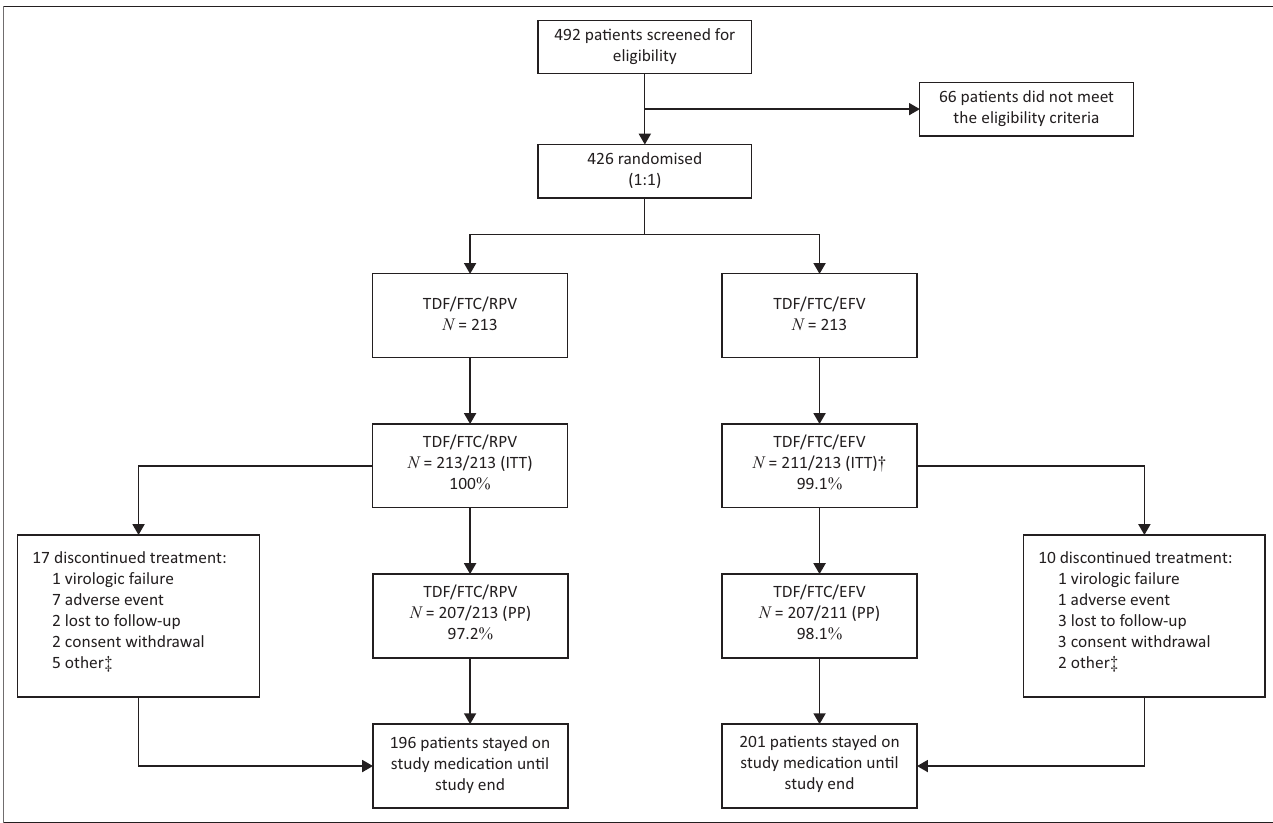
FIGURE 1: Patient